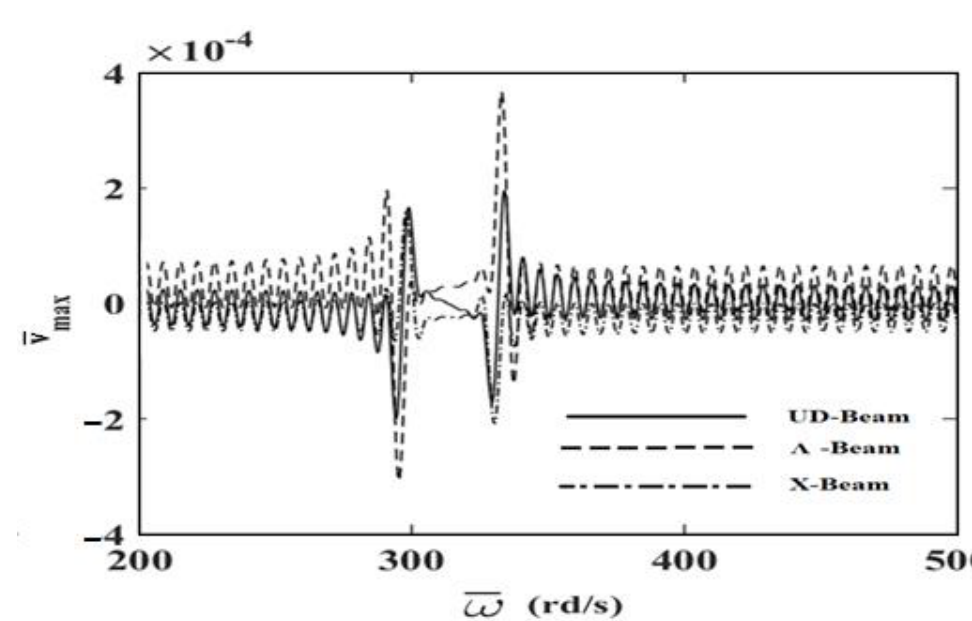
Figure 5. The relationship between the displacements and the frequency of the dynamic load ( 𝑤̅ ) for V CNT = 0.12.